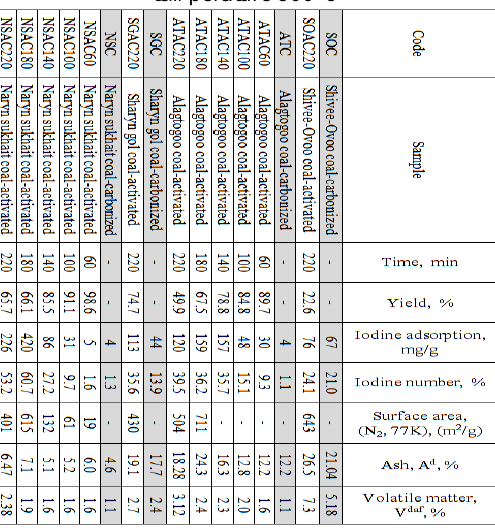
Table 3. Properties of the active carbons obtained at temperature 800°C